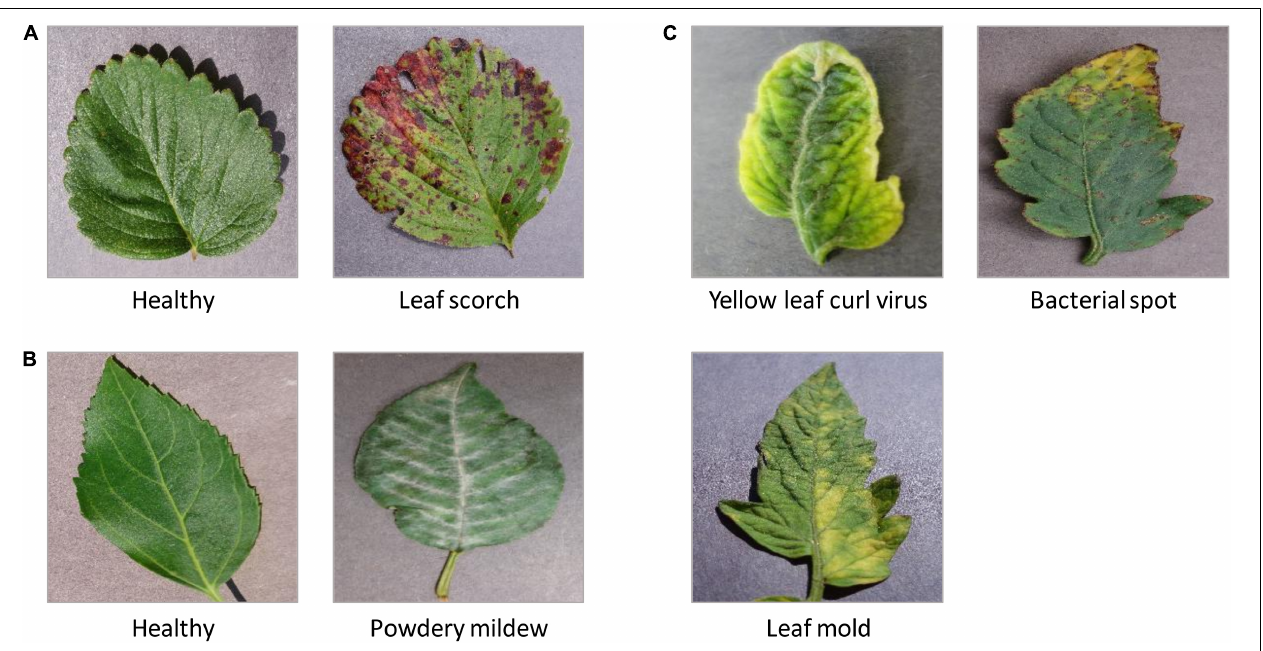
FIGURE 3 | The representative leaf images with diseases from PlantVillage. (A) Leaf scorch of strawberry; (B) cherry powdery mildew; (C) three types of leaf diseases on tomatoes: a bacterial spot of tomato, tomato leaf mold, and tomato yellow leaf curl virus